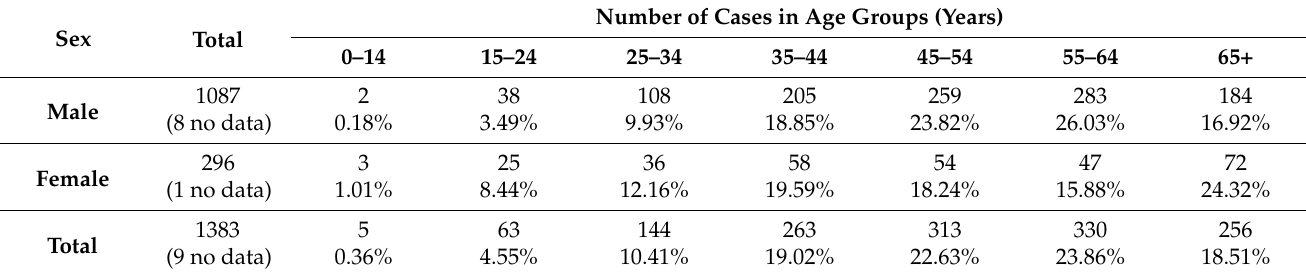
Table 1. Tuberculosis incidence in Poland in 2020, by age and